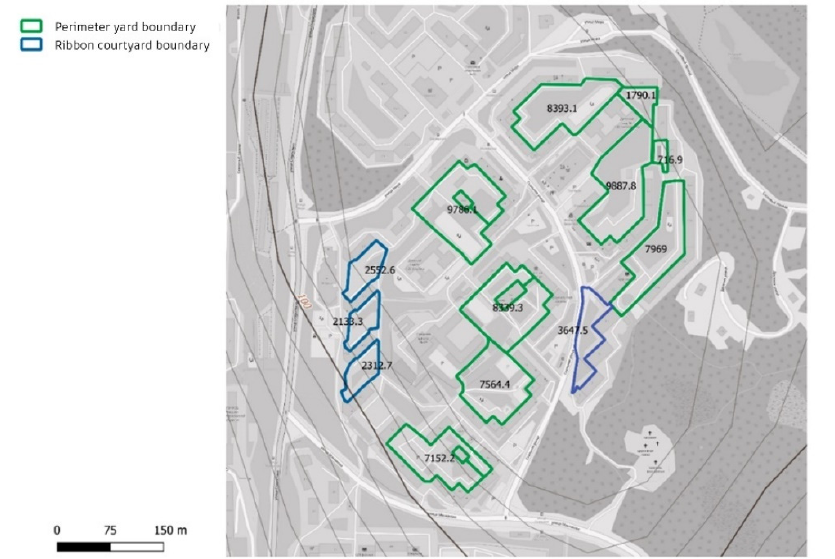
Figure 24. Dimensions of courtyard areas in Neighborhood 403, Murmansk. Table 8. Results of simulation of Neighborhood 403, Murmansk, needed to determine the share of discomfortable zones in the residential development on the sloping lands of the Arctic zone of the Russian Federation.